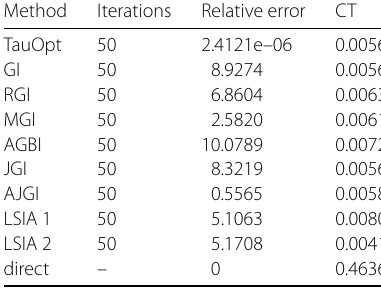
Table 5 Relative errors and CTs for Ex.